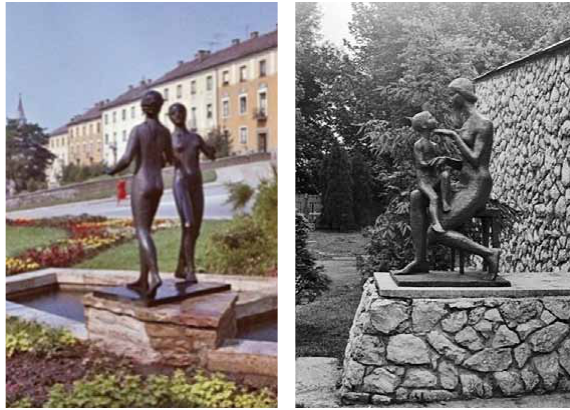
figs 12, 13. Sculptures of different housing